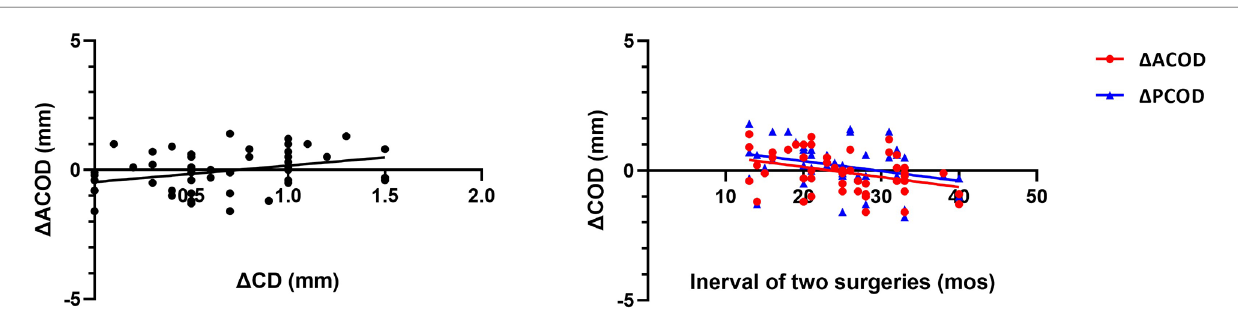
FIGURE 4 Comparisons of the concentrations of IL-15, TNF- α , MCP-1, G-CSF, and FGF-2 in the aqueous humor samples collected at the primary and secondary surgery. PAQ, aqueous humor sample collected at primary surgery; SAQ, aqueous humor sample collected at secondary surgery.